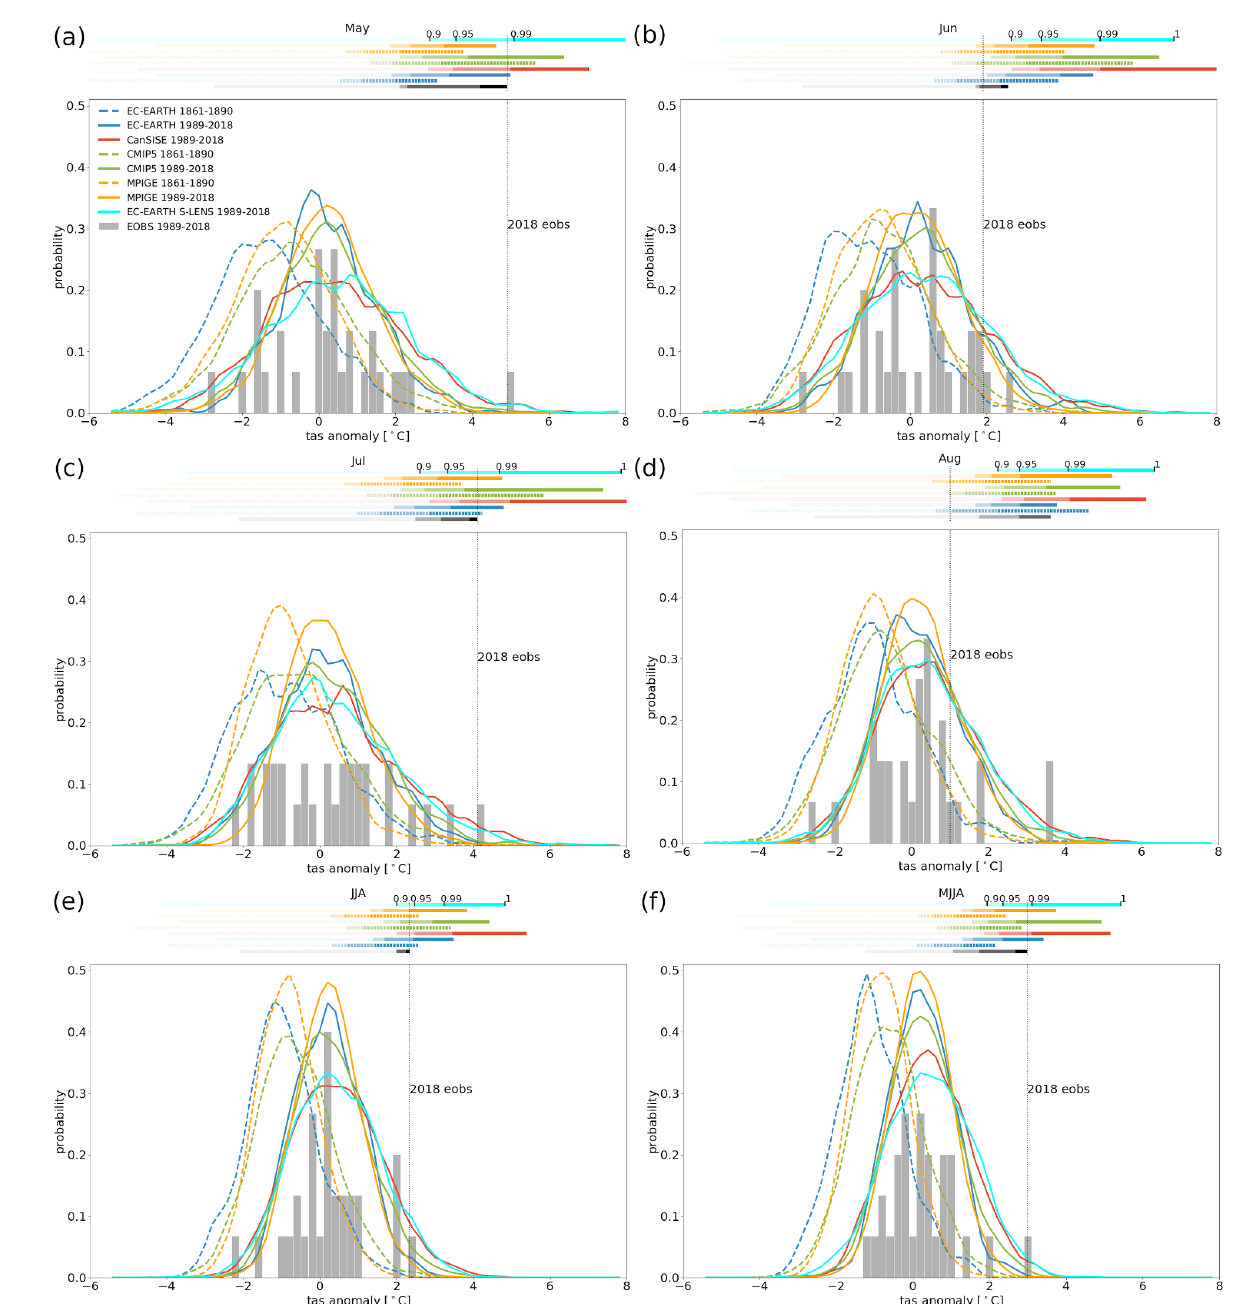
Figure 2. Probability distributions for monthly average temperature anomalies, calculated for 1861–1890 (dashed) and 1989–2018 (solid) against 1981–2010 for the southern half of Sweden, for the individual months of May–August as well as seasonally pooled for JJA and MJJA respectively. The bars in the upper part of each panel are a guide to compare the positions of percentiles for each ensemble and period. The opacity of the bars indicates (in steps) the 90th, 95th, 99th, and 100 percentile ranges marked on the uppermost bar. Ensemble distributions are a kernel density fit, whereas the histogram for E-OBS is based on actual data. The observed year 2018 for respective months or season is indicated by the vertical dotted black